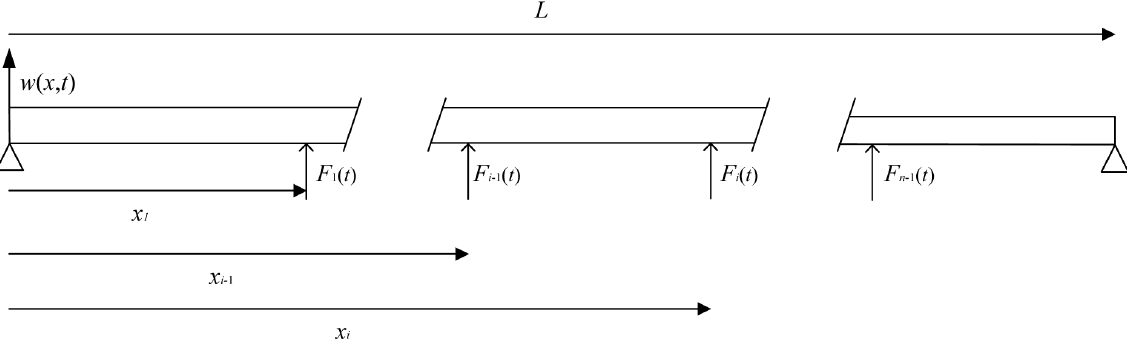
Fig. 2. Multi-span beam with intermediate supports, replaced by time-dependent